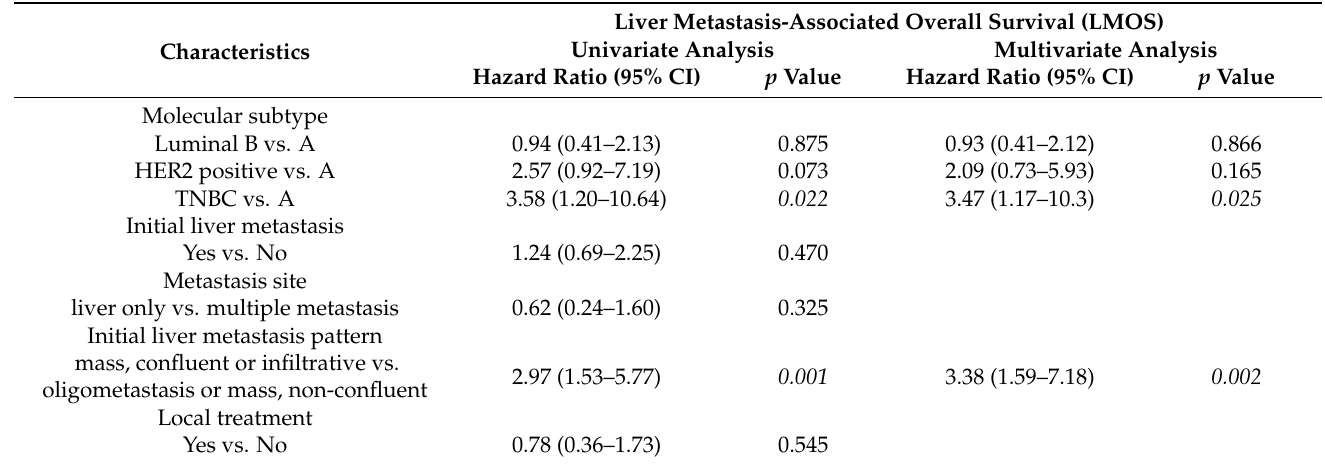
Figure 2. Survival outcome in total patients . ( A ) LMOS according to initial radiologic pattern of liver metastasis ; ( B ) LMOS according to molecular subtypes ; ( C ) LMOS according to L1CAM expression ; ( D ) LMOS according to YAP/TAZ expression; ( E ) LMOS according to positive expression for both L1CAM and YAP/TAZ . LMOS—liver metastasis-associated overall survival; HR—hazard ratio; CI—confidence interval; L1CAM—L1 adhesion molecule; YAP/TAZ—Yes-associated protein 1/Transcriptional co-activator with PDZ-binding motif . Table 3. Cox-regression analysis of the relationship between clinicopathologic parameters and